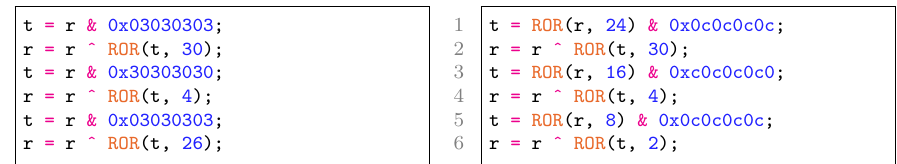
refers to the i -th bit of the j -th block. j